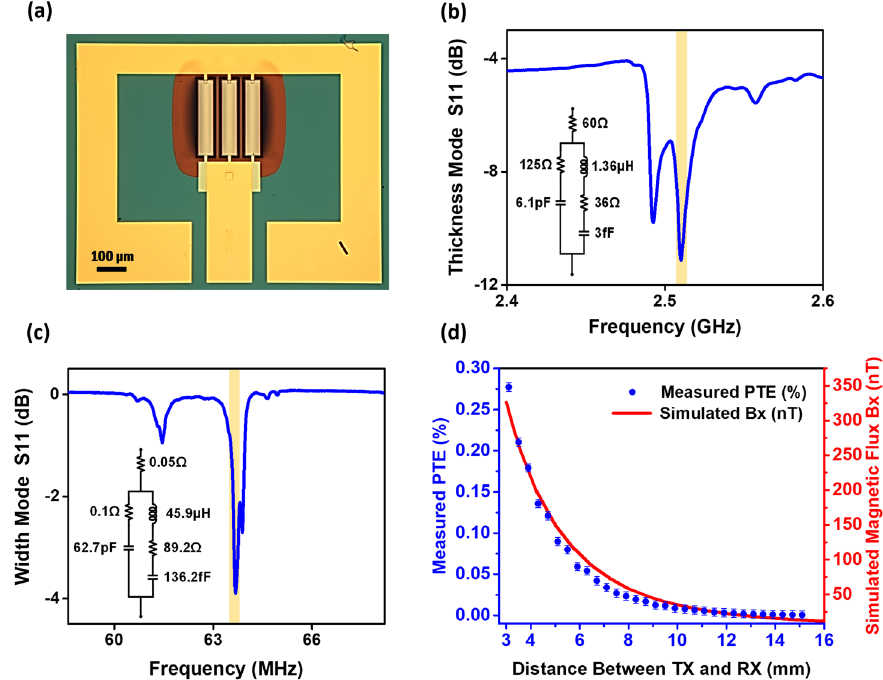
Fig. 2 ME antenna optical image and measurement results. a Optical microscope image of a fabricated smart ME antenna; b S 11 of the thickness mode of the smart ME antenna showing a resonance frequency at 2.51 GHz; c S 11 of the width mode of the smart ME antenna showing a resonance frequency at 63.6 MHz. The insets in ( b ) and ( c ) show the equivalent MBVD circuit model of ME antenna in each mode; d The left-axis shows the measured PTE versus distance between ME antenna and Tx coil, and the right axis shows the simulated magnetic fl ux density along the x-axis (Bx) generated by the Tx coil versus distance from Tx